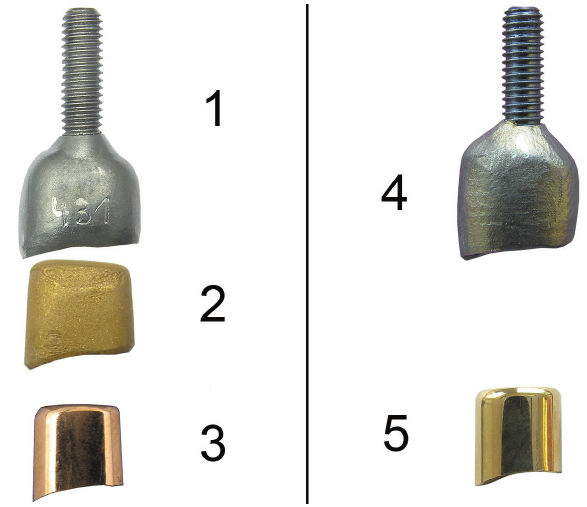
conical crown. At right a specimen using a cast female of the same gold